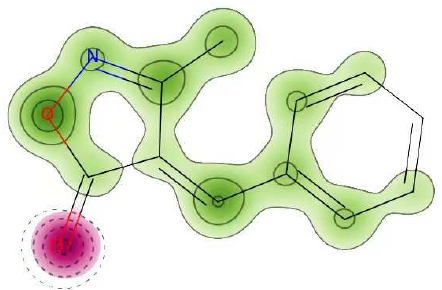
Figure 10. Cardiac toxicity of MBO derived from pred-hERG in a map